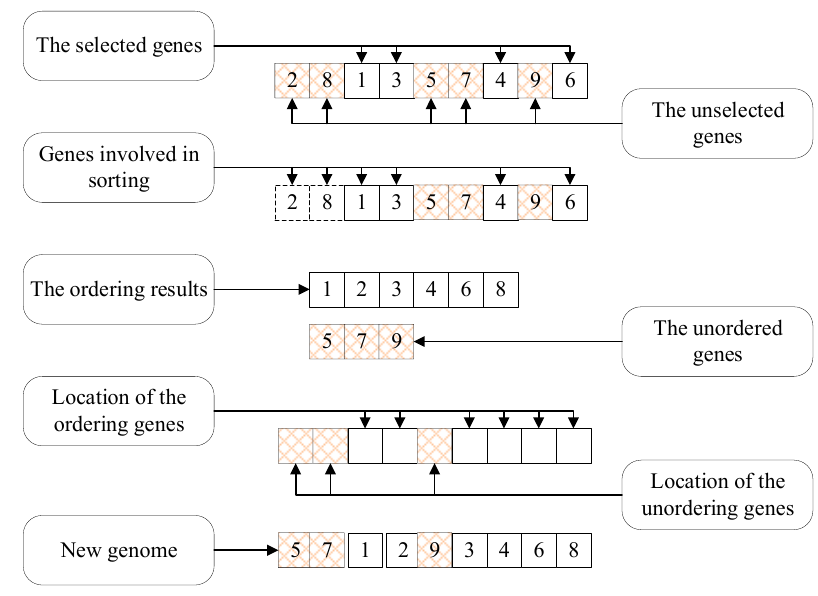
Figure 7. The mutation process of the time partially ordering mutation operator (TPOMO).